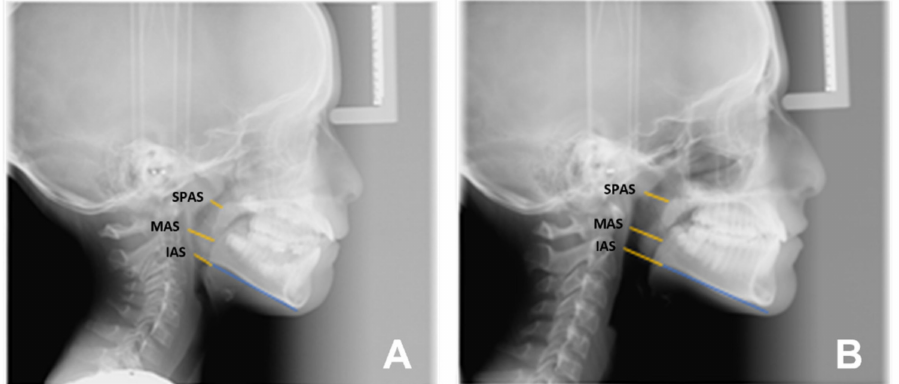
Figure 3. ( A , B )—Patient V.B. airways cephalometry, before ( A ) and after ( B ) treatment. Indicated with a yellow line, SPAS superior posterior airway space (width of airway behind soft palate along a line parallel to Gonion–Menton (Go–Me) plane); MAS medium airway width measured on a line parallel to Go–Me plane passing through tip of soft palate (P); and IAS inferior airway width measured on Go–Me